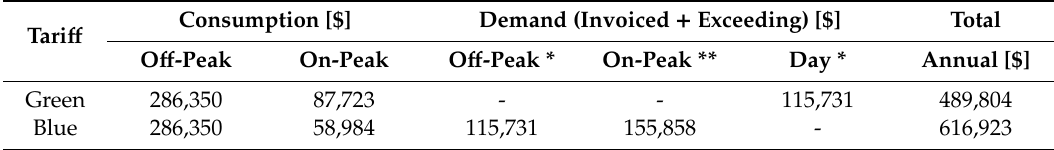
Table 11. Main results for Scenario 7.